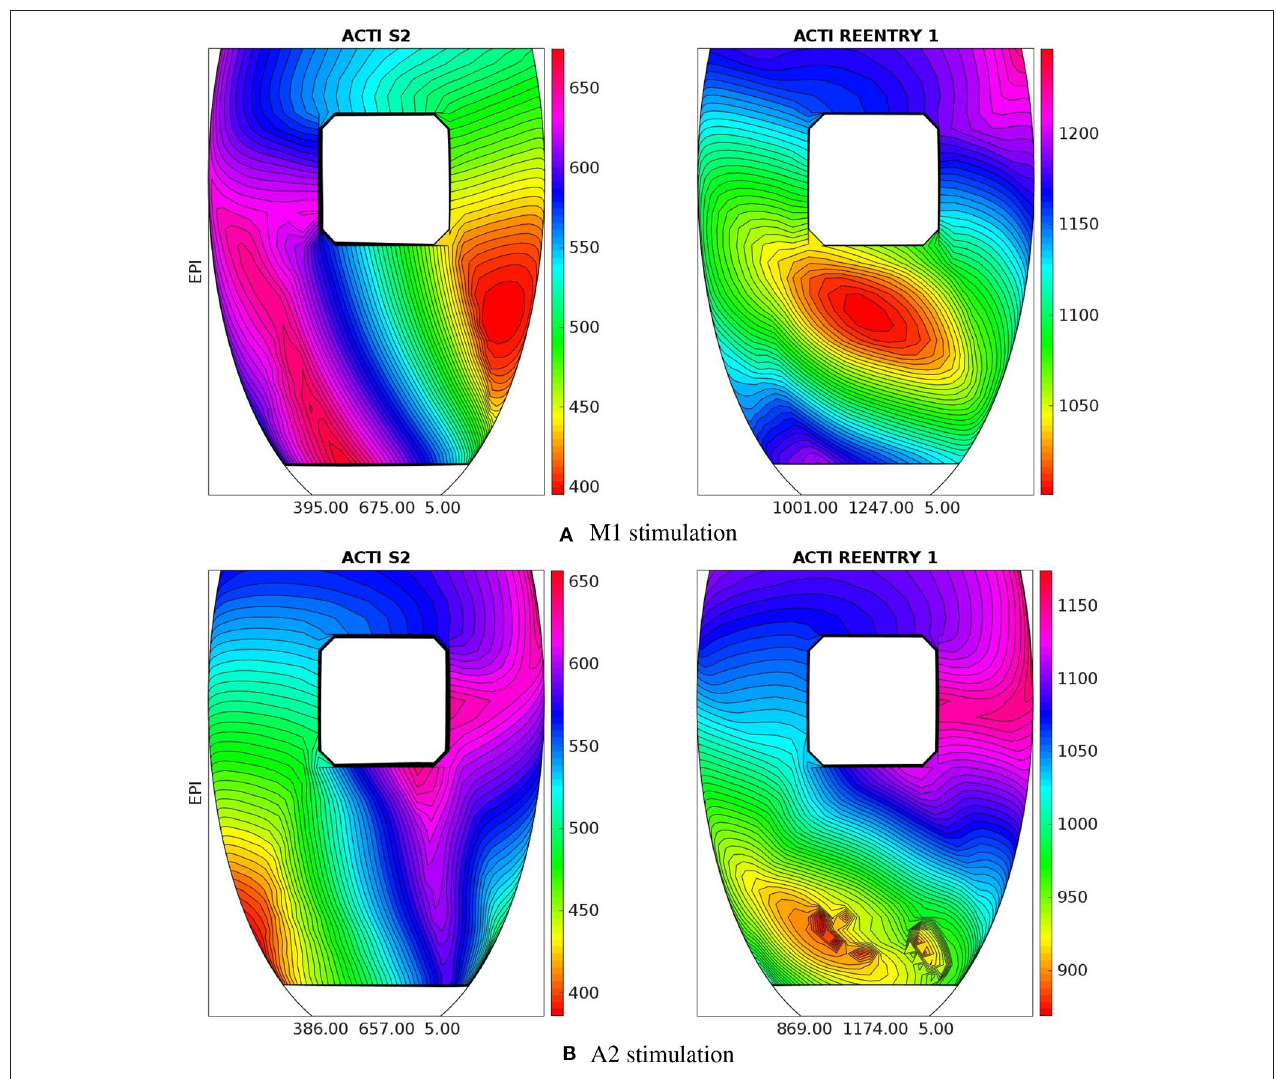
FIGURE 9 | Patient #1. Epicardial activation time distributions of S2 and first reentrant excitation sequences for M1 (A) and A2 (B) stimulations. Below each panel is reported the minimum, maximum, and isochrones step in ms of the displayed